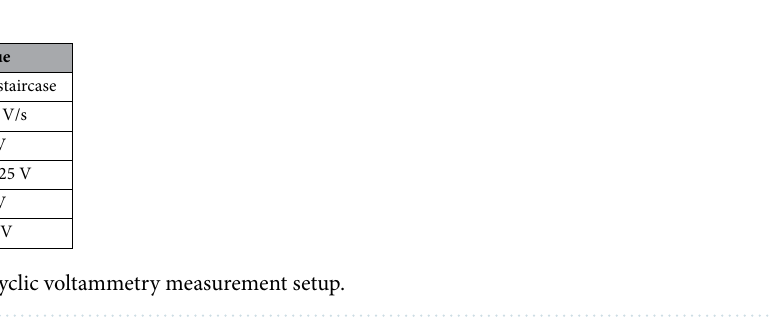
Figure 14. Conducting CV measurements on a BSA sample using SPE Design C connected to an adaptor.